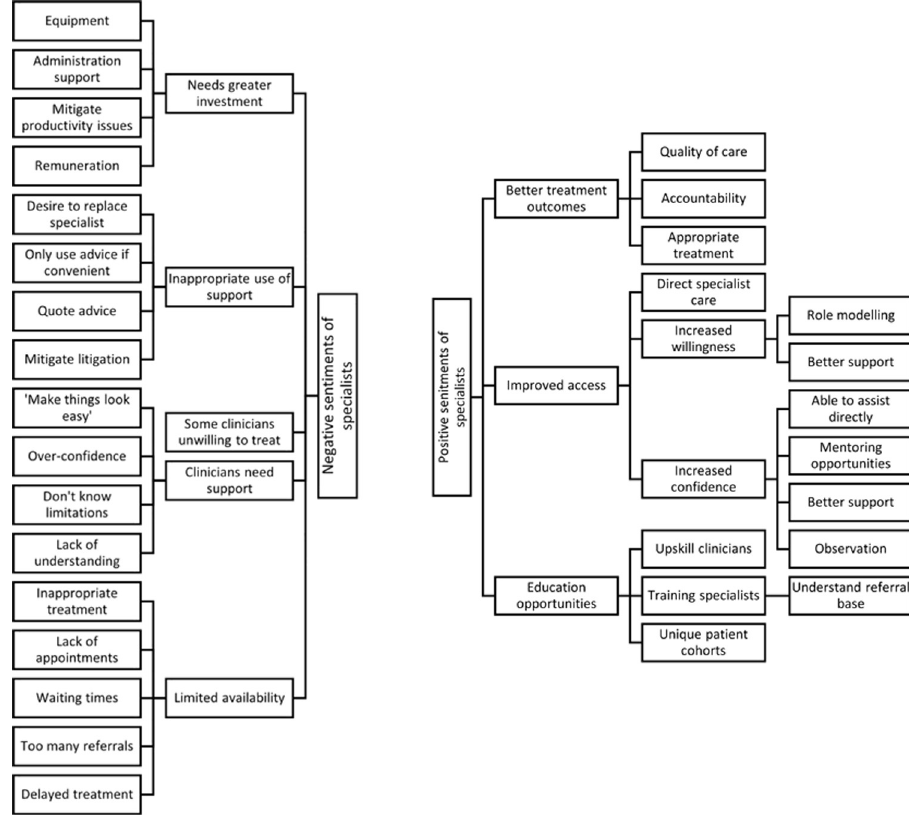
Fig 2. Coding tree for specialist